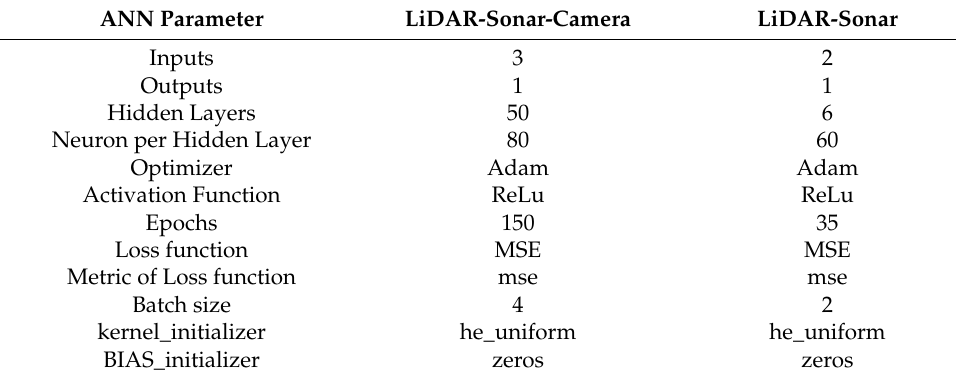
Table 5. Tuning parameters of the NN.